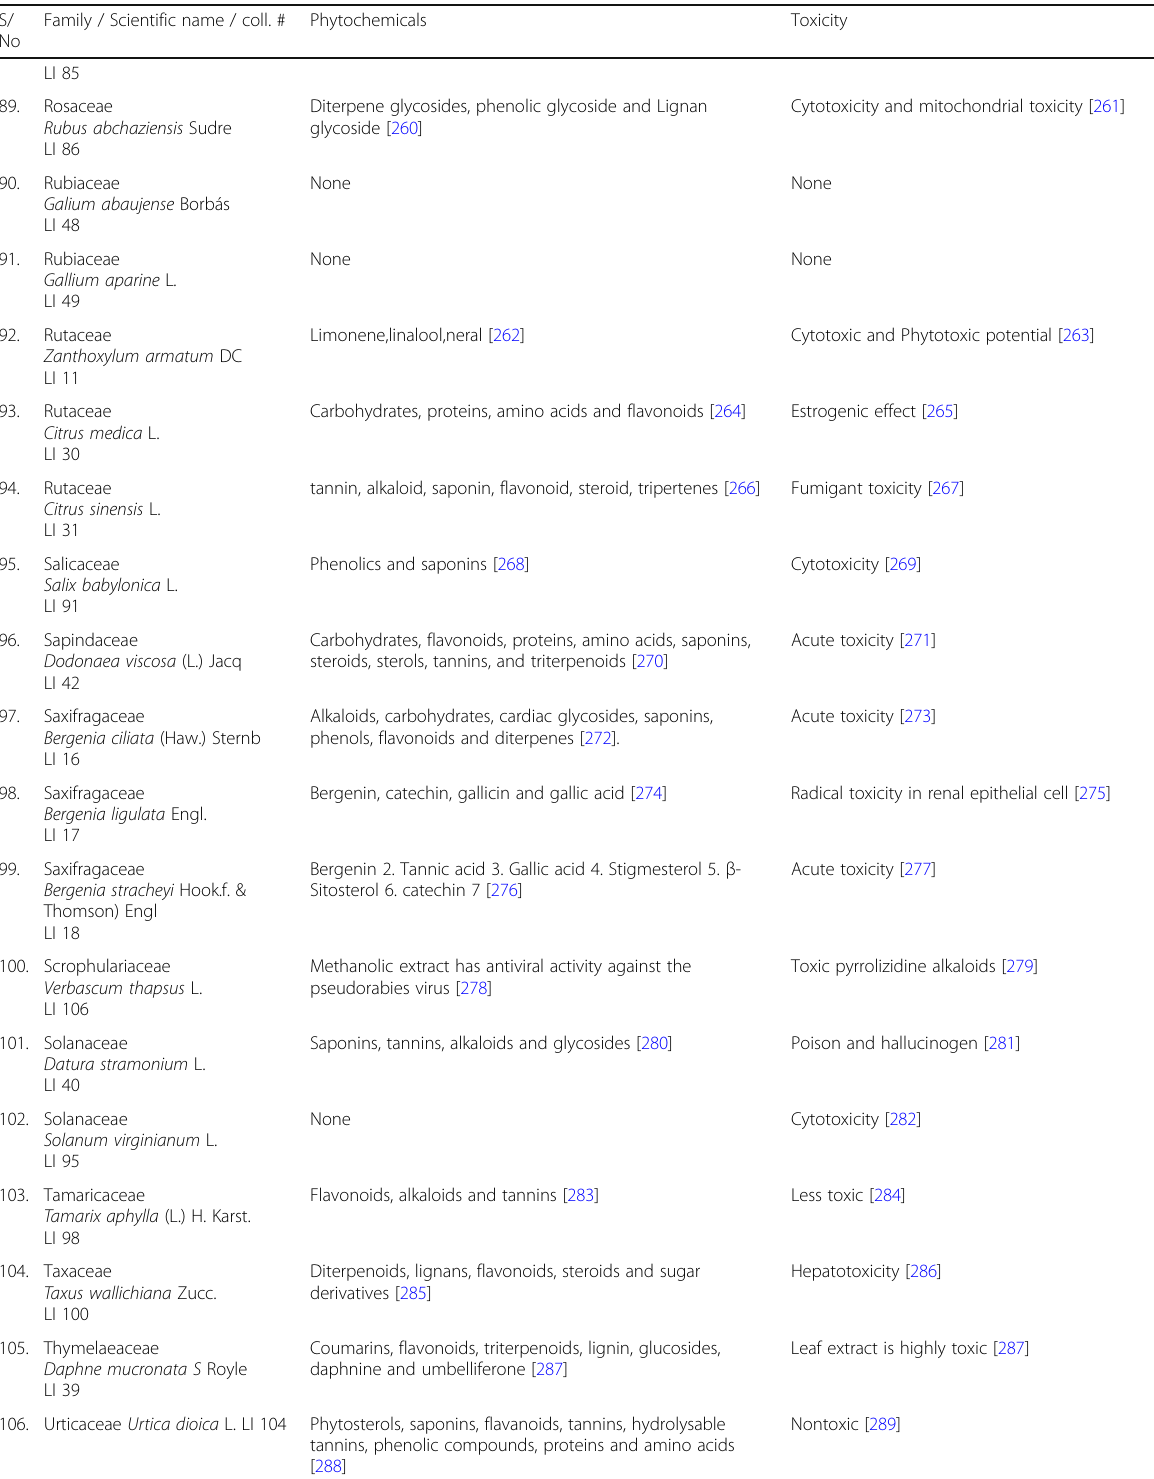
Table 5 Phytochemical activities and toxicity of medicinal plants used for skin diseases (Continued) S/ Family / Scientific name / coll. # No